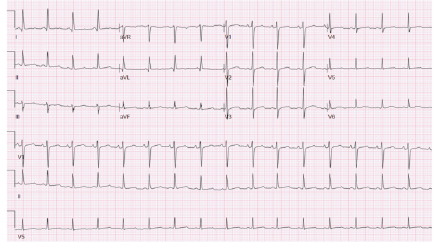
Figure 4: QTc 487 (Day